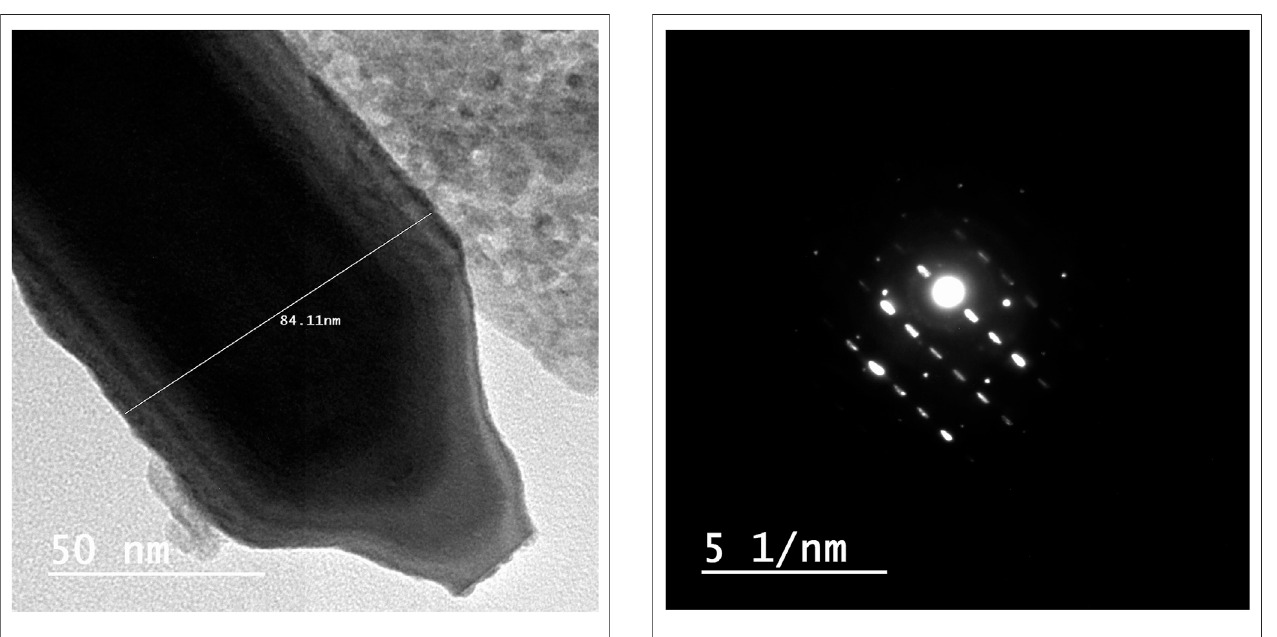
FIGURE 3 | Transmission electron microscopy of ZnO nanorods (ZnO-NRs).